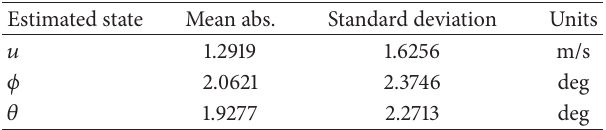
Table 8: Simplified formulation error statistics for Flight #1 with range state.